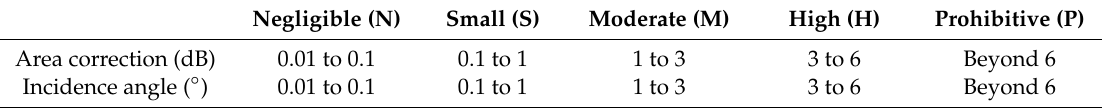
Table 3. Scale adapted from [9] to classify the magnitude of uncertainty in area correction and incidence angle. Negligible (N) Small (S) Moderate (M) High (H) Prohibitive (P) Area correction (dB) 0.01 to 0.1 Incidence angle ( ◦